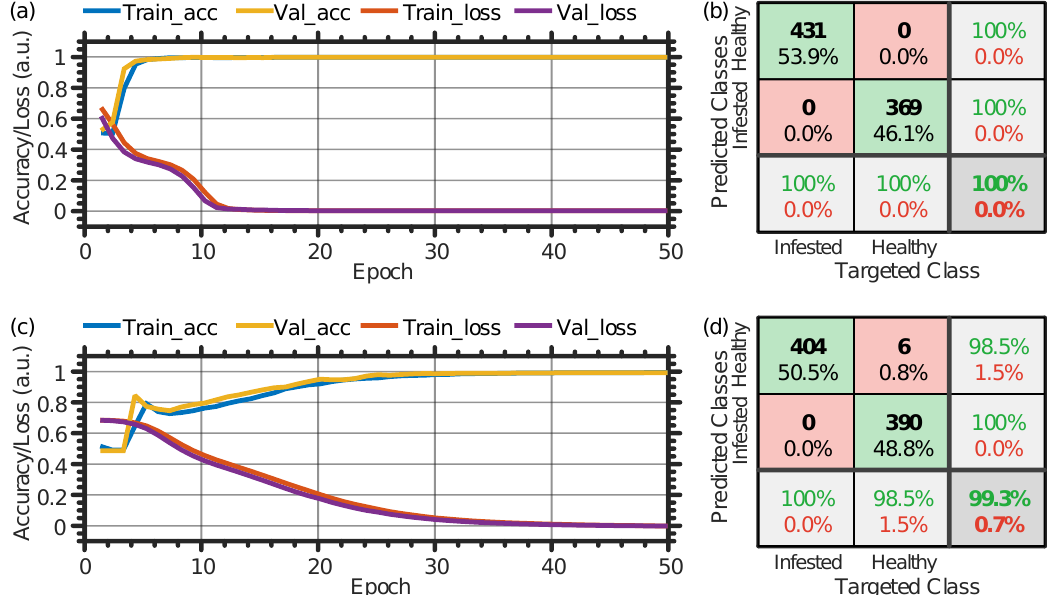
Figure 12. Training and validation history ( a / c ) and confusion matrix ( b / d ) when ignoring the wind and using the temporal/spectral dataset with the CNN. Train_acc: training accuracy; Val_acc: validation accuracy; Train_loss: training loss; Val_loss: validation